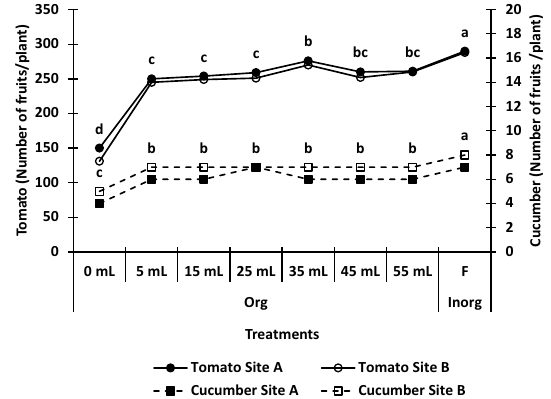
Figure 1. Effect of organic and in-organic fertilizers on number of fruits of tomato and cucumber under soilless medium. Values followed by similar letters under the same graph are not significantly different at p =